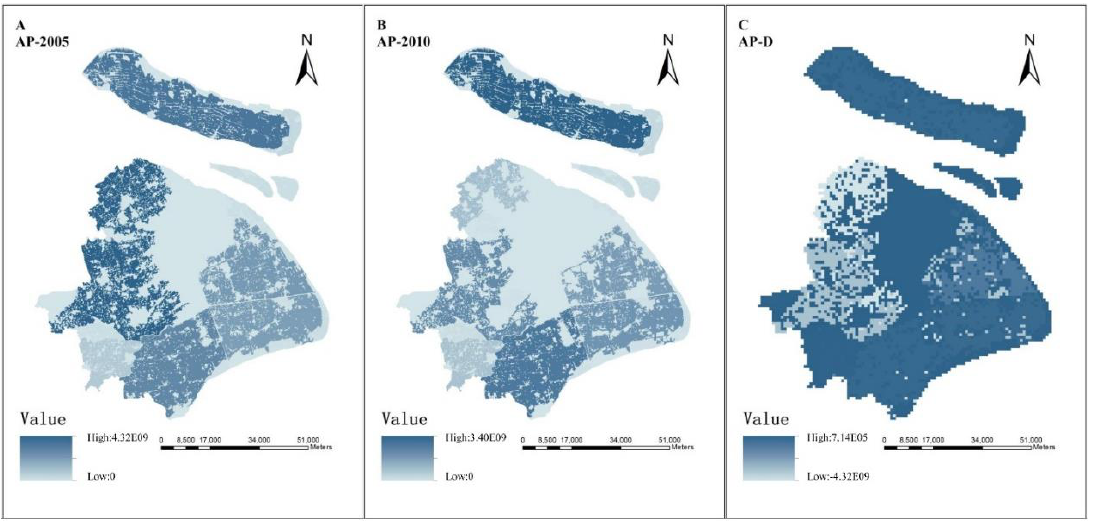
11 of 26 Figure 5. Contributions from main districts to land-use change. Spatial distributions and changes of the considered ESs are shown in Figures 6–10. Spatial values of ESs at the district level were illustrated in Figure 11. For AP, Chongming had the largest contribution, accounting for 21.70% and 23.74% of the total AP in 2005 and 2010, respectively, followed by Pudong and Fengxian. Regarding CS, Chongming had also the largest contribution, accounting for 21.14% and 21.74% of the total in 2005 and 2010, respectively, followed by Pudong and Fengxian. Pudong contributed 19.16% and 18.67% to the total SC in 2005 and 2010, respectively, followed by Chongming and Fengxian. In 2010, Chongming had the highest emergy value of biodiversity, with a figure of 3.14 × 10 30 sej, followed by Pudong and Jinshan. When considering the total regulating ESs as a whole, Chongming had the highest value of ESs, with figures of 7.03 × 10 19 sej in 2005 and 6.87 × 10 19 sej in 2010, followed by Pudong (6.67 × 10 19 sej in 2005 and 5.86 × 10 19 sej in 2010), Fengxian (4.21 × 10 19 sej in 2005 and 3.99 × 10 19 sej in 2010), Jinshan (3.62 × 10 19 sej in 2005 and 3.51 × 10 19 sej in 2010), Qingpu (3.46 × 10 19 sej in 2005 and 3.21 × 10 19 in 2010), and Songjiang (3.24 ×